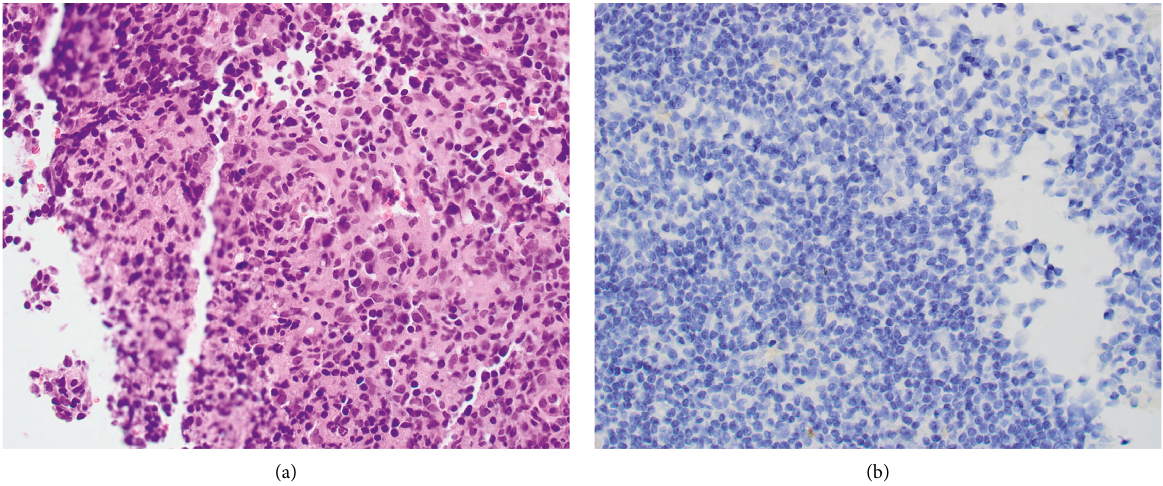
Figure 6: (a) H&E stained LN needle biopsy section showing a non-necrotizing granuloma with no evidence of lymphoid infiltrate (x200). (b) Immunohistochemically stained lymph node needle biopsy section showing negative staining for TdT